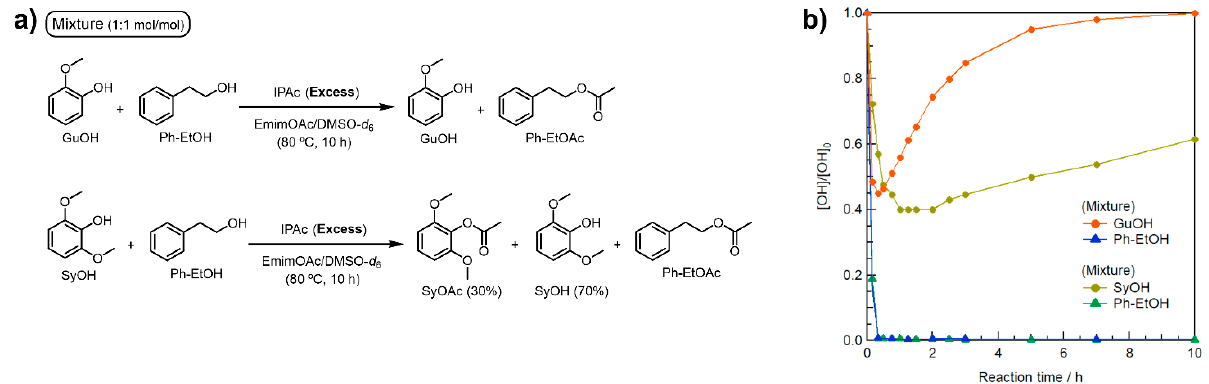
Figure 3. ( a ) Schematic representation of model reactions in EmimOAc/DMSO-d 6 : transesterification of equimolar mixtures of GuOH or SyOH with Ph-EtOH using IPAc as an acyl donor. ( b ) Effect of mono- or di-OMe groups at the o -positions of Ar-OH groups on the transesterification of mixtures of GuOH or SyOH with Ph-EtOH (0.38 mol L − 1 each), excess IPAc (1.14 mol L − 1 ), and EmimOAc (3.8 mol L − 1 ) for 10 h at 80 °C determined as changes in relative contents by in situ 1 H NMR in DMSO- d 6 .